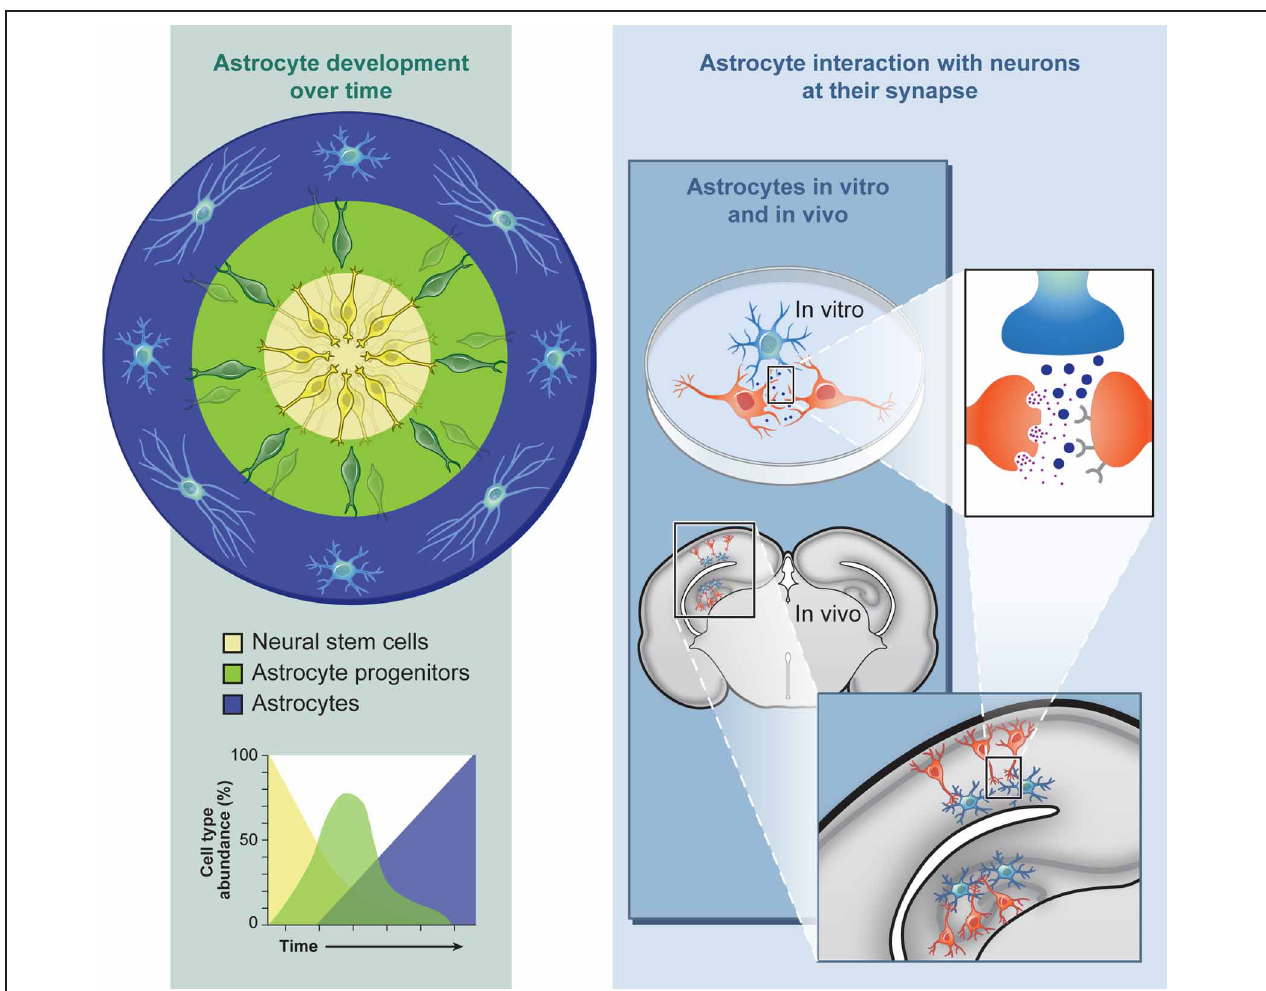
FIGURE 1 | Astroglial differentiation from human pluripotent stem cells allows for the investigation into neurodevelopmental and functional aspects of neurological and neurocognitive disorders in culture or after engraftment into intact nervous